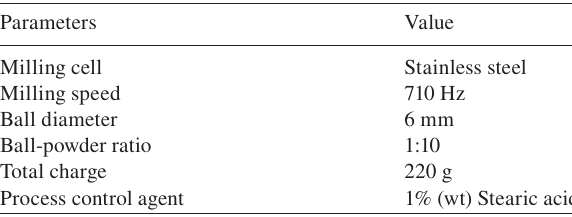
Table 1 Details of the device and milling parameters. Parameters Value Milling cell Stainless steel